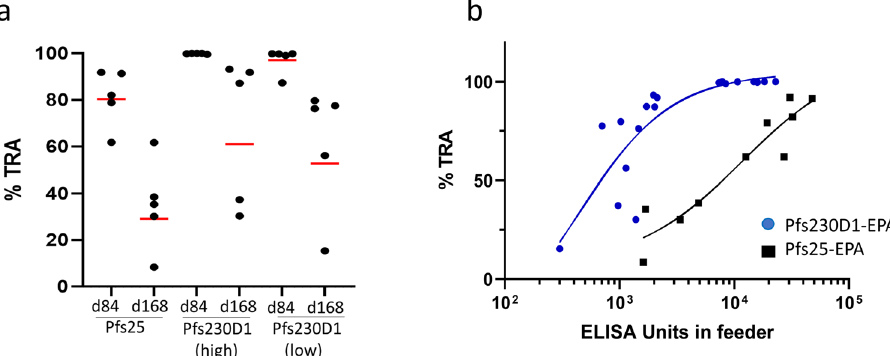
Fig. 2 anti-Pfs230 induces superior functional activity than anti-Pfs25 after two immunizations. a transmission reducing activity, by group, 2 weeks (d84) and 14 weeks (d168) after dose 2. Each data point represents TRA from one monkey; red lines denote arithmetic mean TRA. b Nonlinear 4-parameter curve fi t of log (EU) vs TRA. Antibody levels shown account for dilution of immune monkey sera in the feeding assay. An IC 50 was estimated for both antigens using a 4-parameter curve fi t of the log(titer) vs %TRA for each monkey of the d84 and d168 SMFA data combined. Correlation analysis of ELISA vs TRA showed strong correlation for both antigens. Pfs230D1: Spearman r = 0.92, p < 0.0001; Pfs25: Spearman r = 0.94, p <